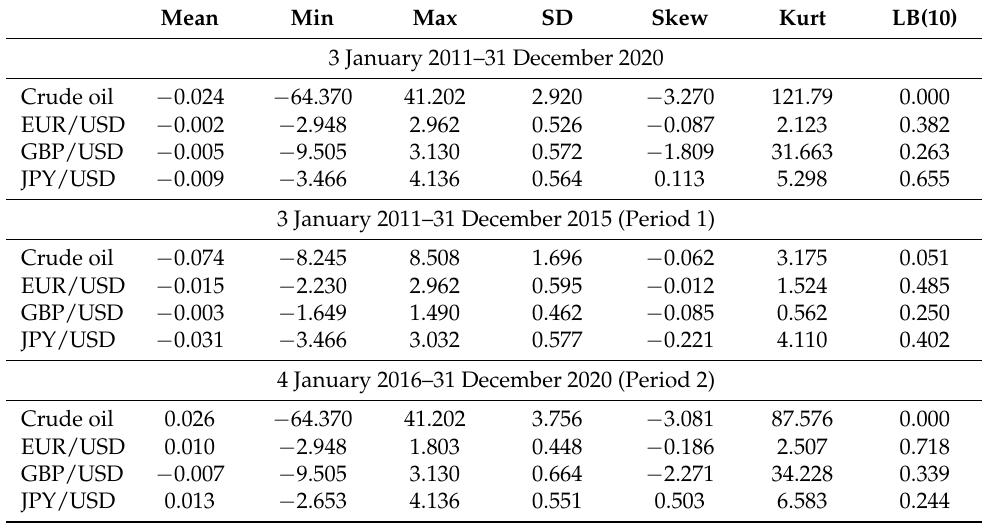
Table 1. Descriptive statistics of the investigated